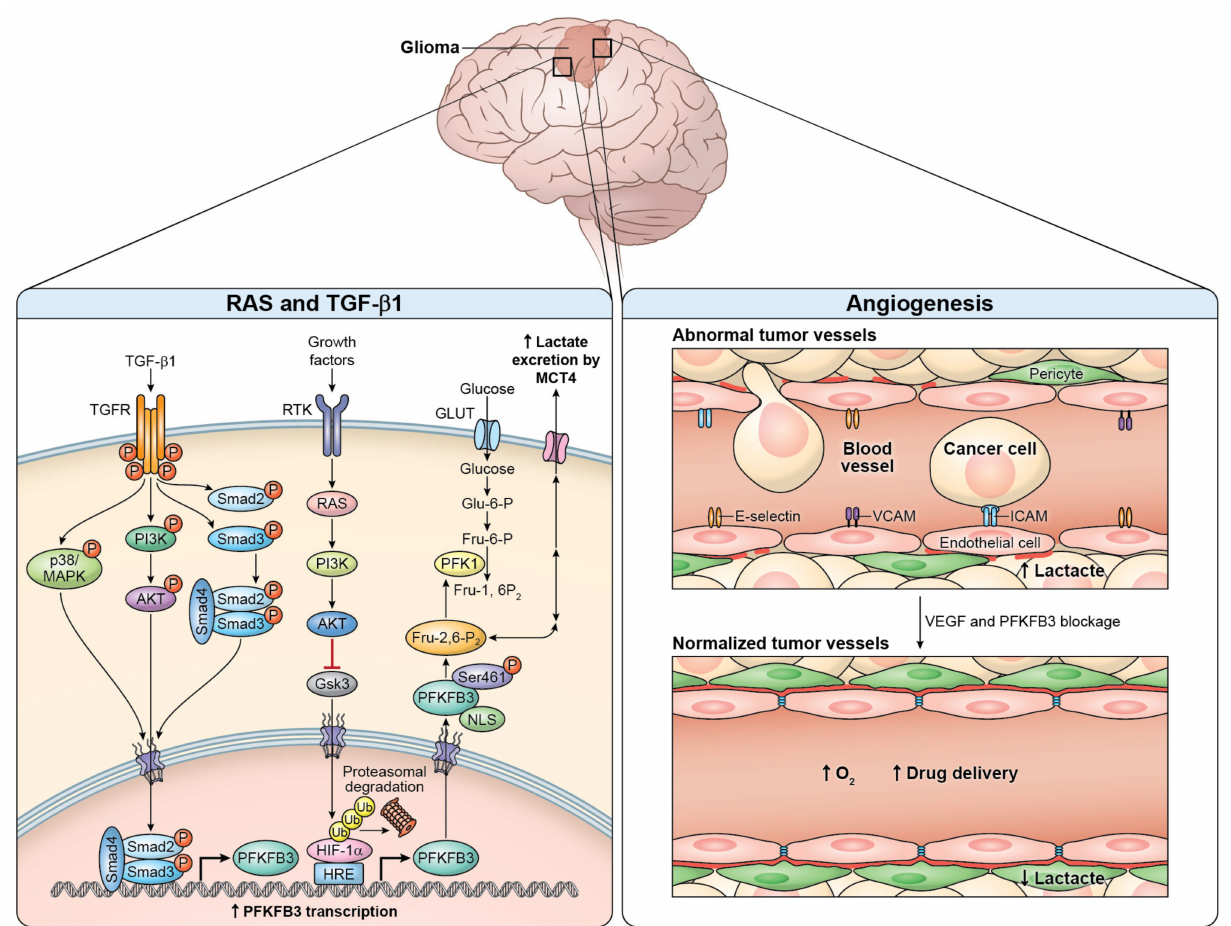
Figure 2. PFKFB3 tumorigenesis in gliomas. Oncogenic mediators RAS and TGF- β 1 have been found to be primary drivers of PFKFB3 overexpression in high-grade gliomas. Tumorigenic angiogenesis in gliomas is promoted by PFKFB3 expression in tumor endothelial cells. Artist: Ethan Tyler, Medical Arts, Office of Research Services, National Institutes of Health, Bethesda, MD,